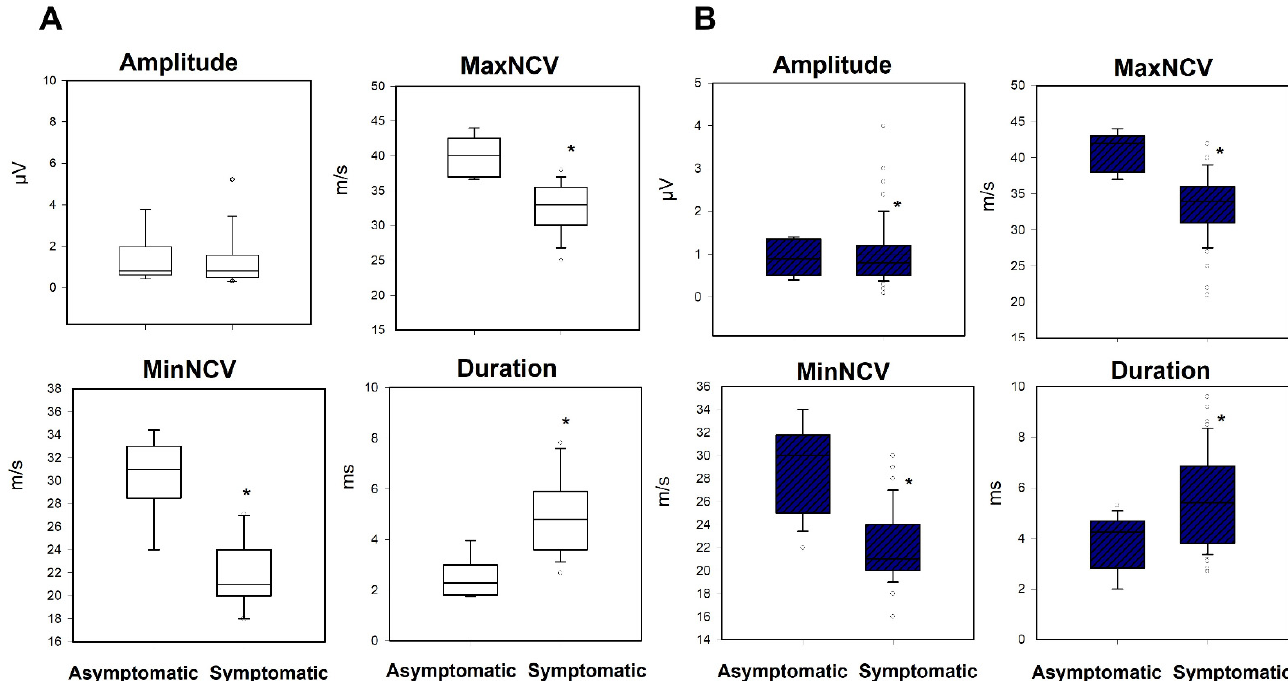
Figure 5. Box-plots comparing the asymptomatic and symptomatic groups for the variables amplitude, maximum, minimal conduction velocity and duration, for the ( A ) medial and ( B ) lateral nerve. Black asterisk = difference between asymp- tomatic/symptomatic.